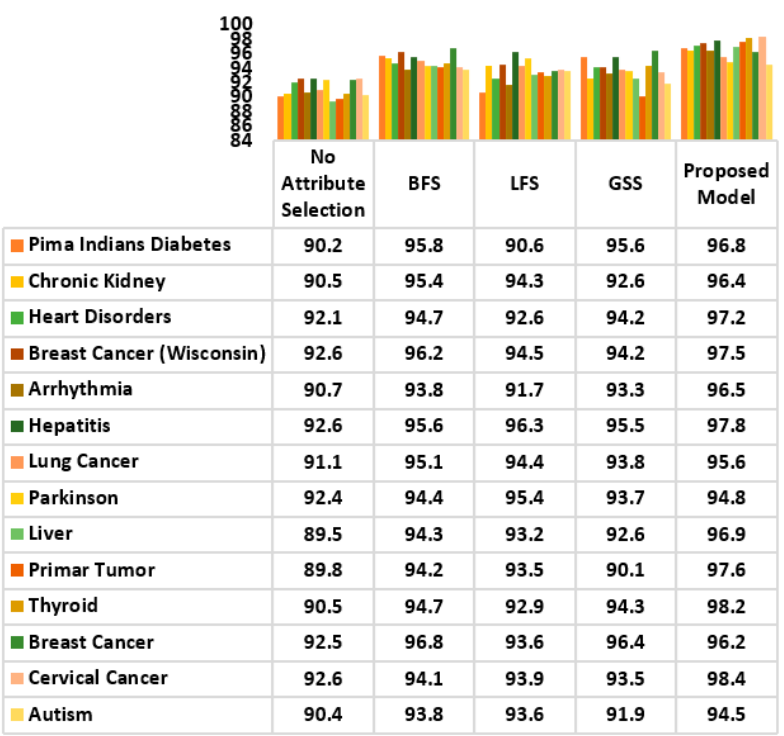
Figure 18. Comparative Study of the Classification Accuracy of the Proposed Attribute Evaluator Method and Other Filter Methods.